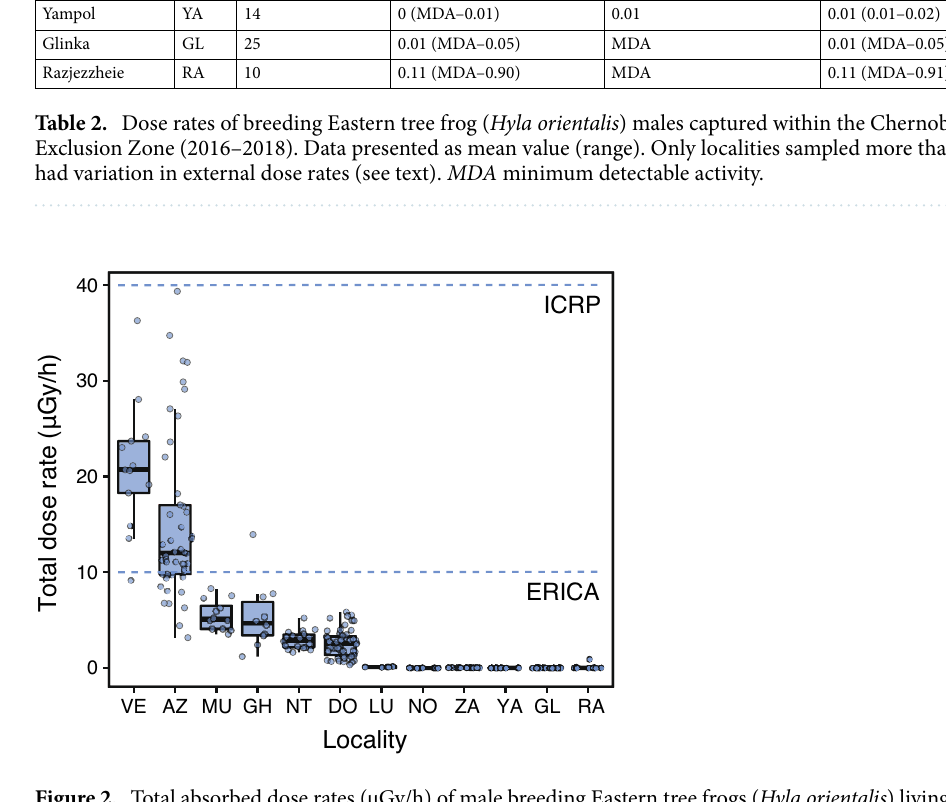
Figure 2. Total absorbed dose rates (μGy/h) of male breeding Eastern tree frogs ( Hyla orientalis ) living within Chernobyl Exclusion Zone. ICRP’s 40 μGy/h level for detecting damage on the reference frog, and ERICA’s 10 μGy/h screening level for protecting organisms within ecosystems are depicted with dotted lines. See Fig. 1 for correspondence of